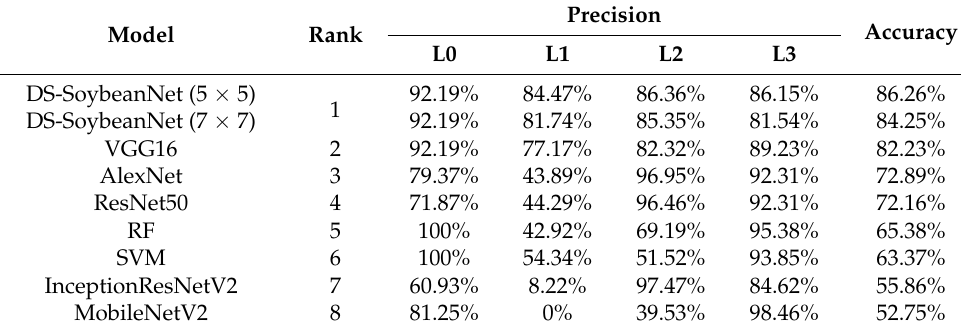
Table 9. Classification results of eight models from field